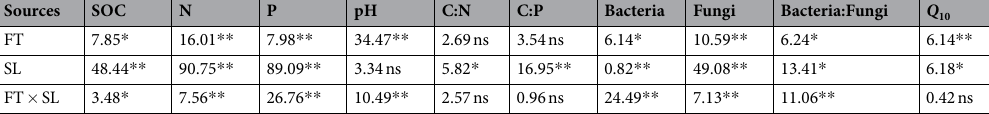
Table 1. Results of two factors ANOVA showing the F and P values for responses of soil properties to forest type (FT) and soil layers (SL). * p < 0.05, ** p < 0.01, ns: not